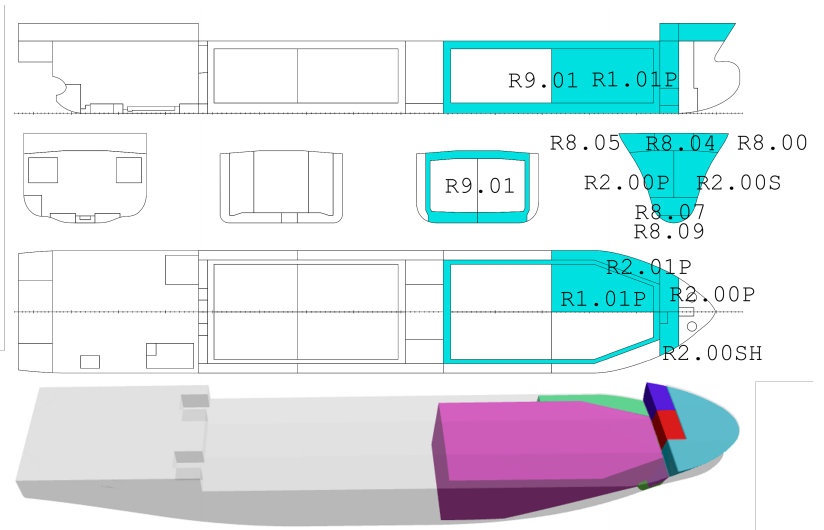
Figure 7. Illustration of damage case DAM04.